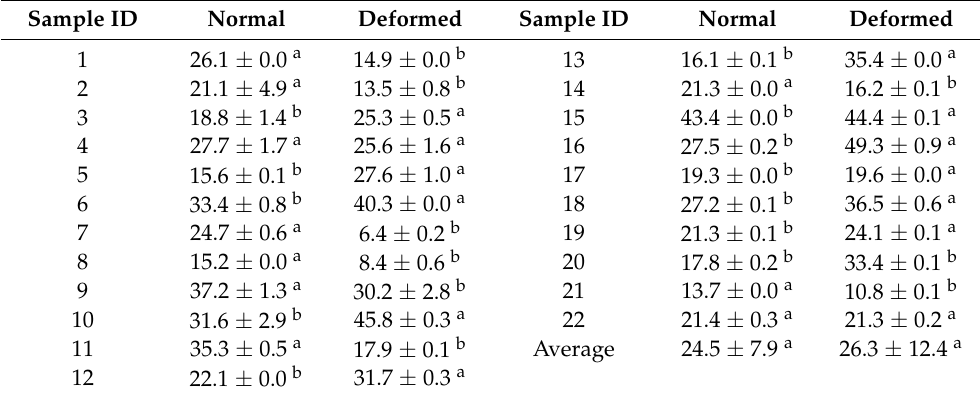
Table 1. Cadmium contents of 22 samples of normal and deformed sporocarps of B. griseus (mg · kg − 1